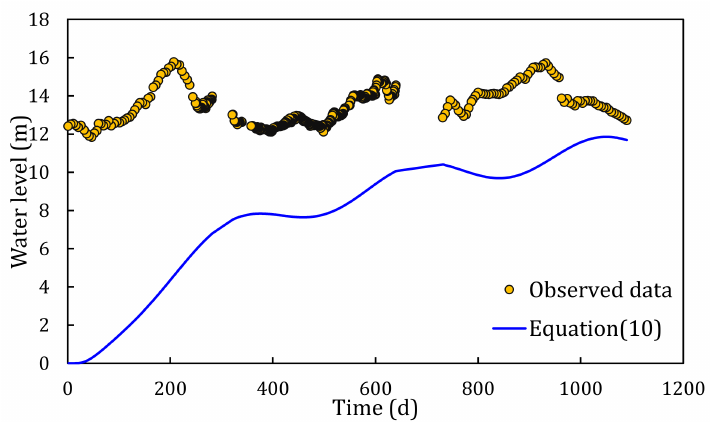
Figure 8. Comparison of calculated values and observed data ( x = 1700